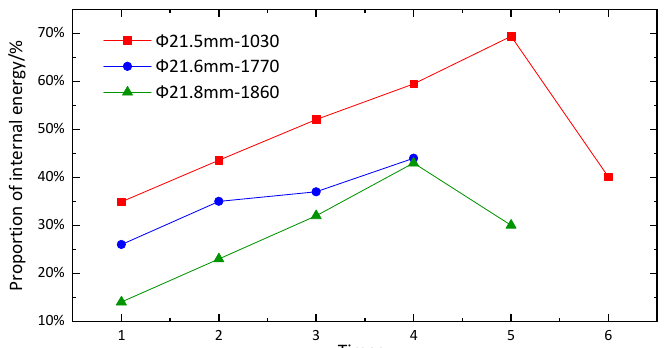
Figure 12. The relationship between the ratio of internal energy to the total impact energy and impact times.